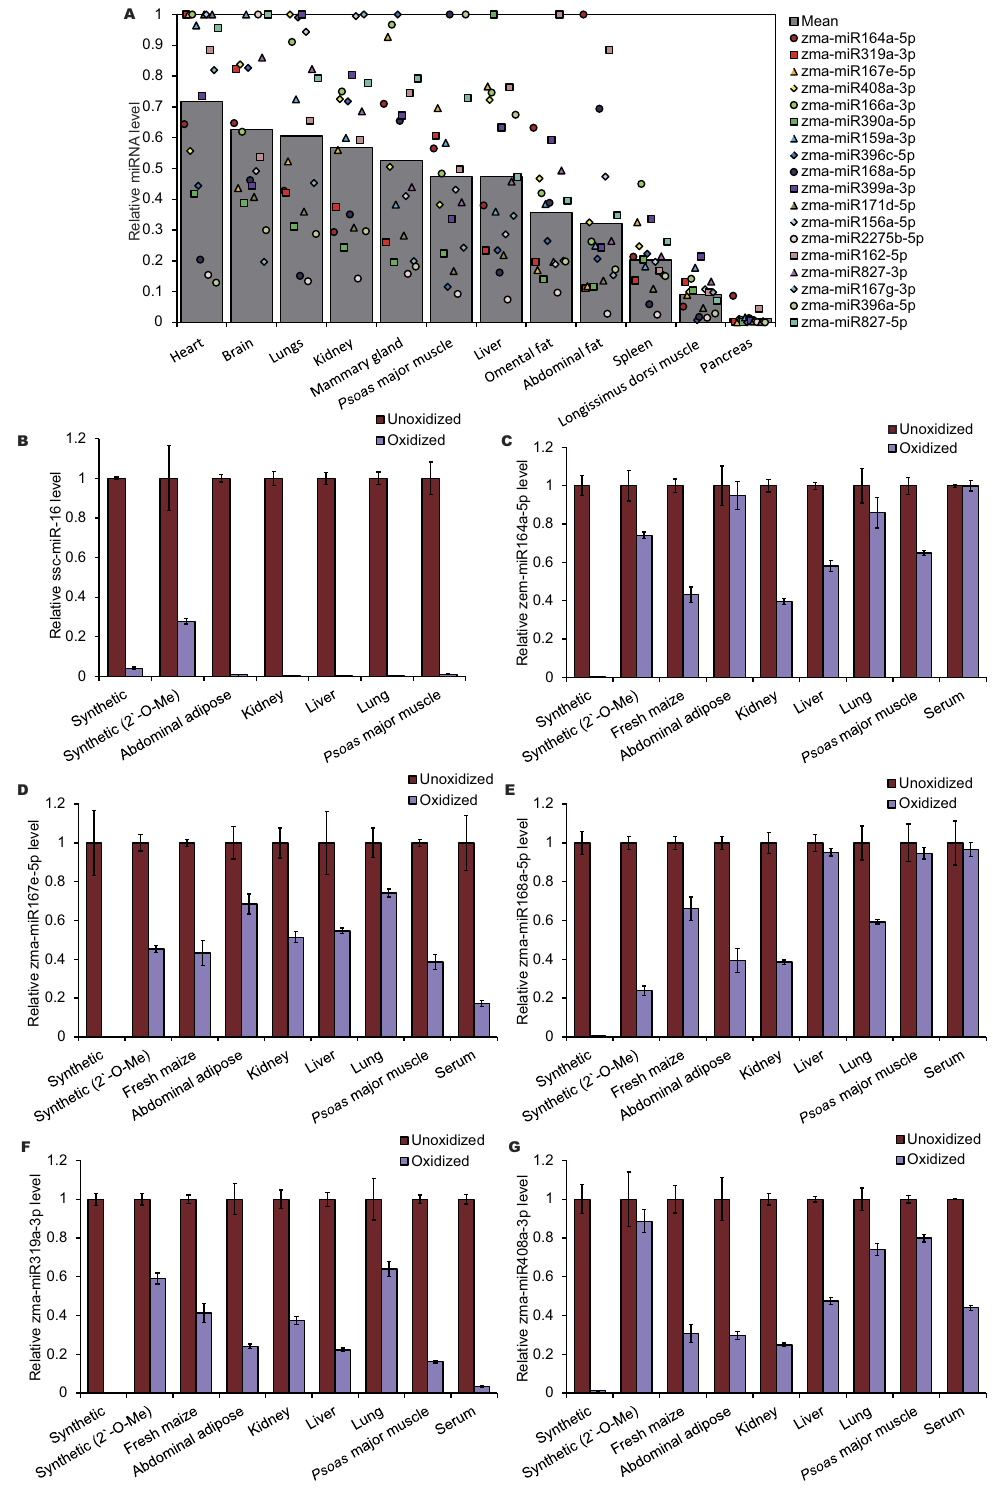
Figure 2. Maize miRNAs are present in porcine nonsolid (blood) and solid tissues. ( A ) The relative expression levels (miRNA/18S, 5S, U6) of 18 plant miRNAs in 12 porcine tissues were detected by qRT-PCR ( n = 3). Data were normalized to the levels of porcine 18S, 5S and U6, and then plotted relative to the highest levels in the tissues. ( B–G ) Equal amounts of synthetic plant and porcine small RNAs (with or without 2 ′ -O-methylated 3 ′ ends) and total small RNAs isolated from fresh maize, porcine serum and tissues were treated with/without sodium periodate. After the reactions, the endogenous ( B ) and plant ( C–G ) miRNA levels were detected by qRT-PCR assay. The pigs were fed with fresh maize for 7 days. Data were normalized to the miRNA levels of unoxidized samples ( n =